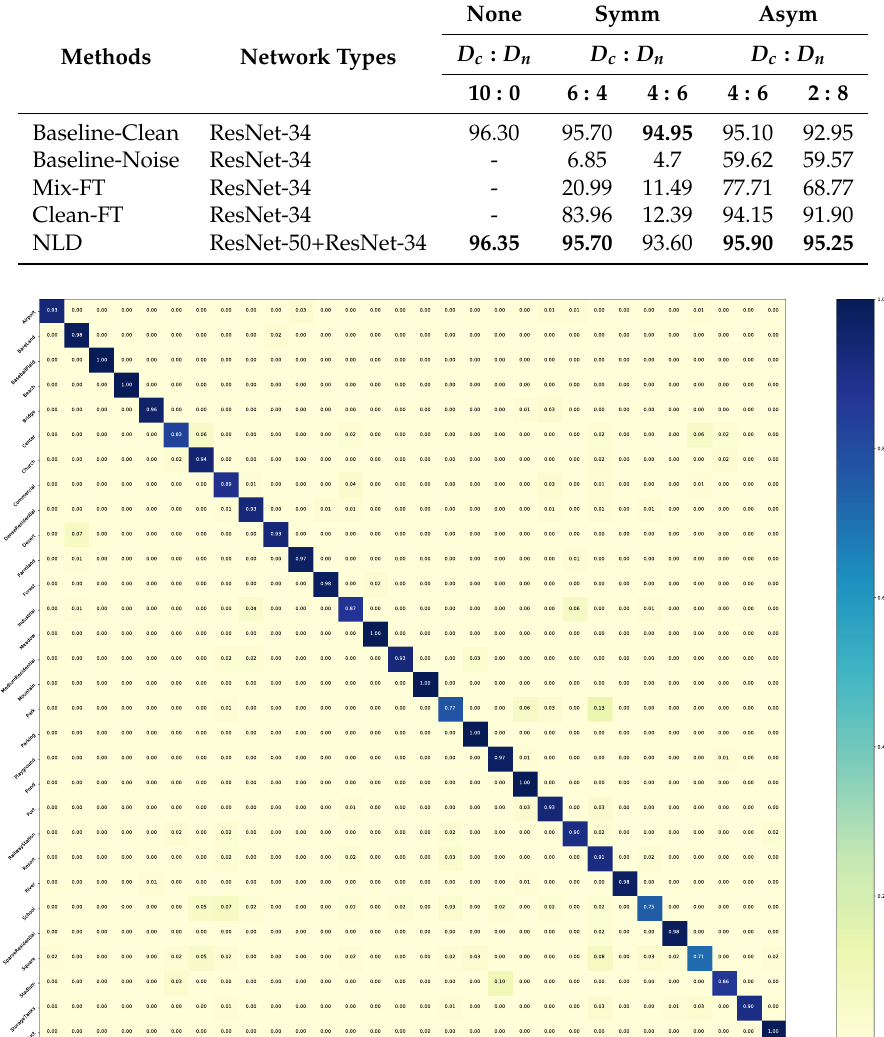
Table 7. Classification accuracy (%) on the AID test set for different methods.